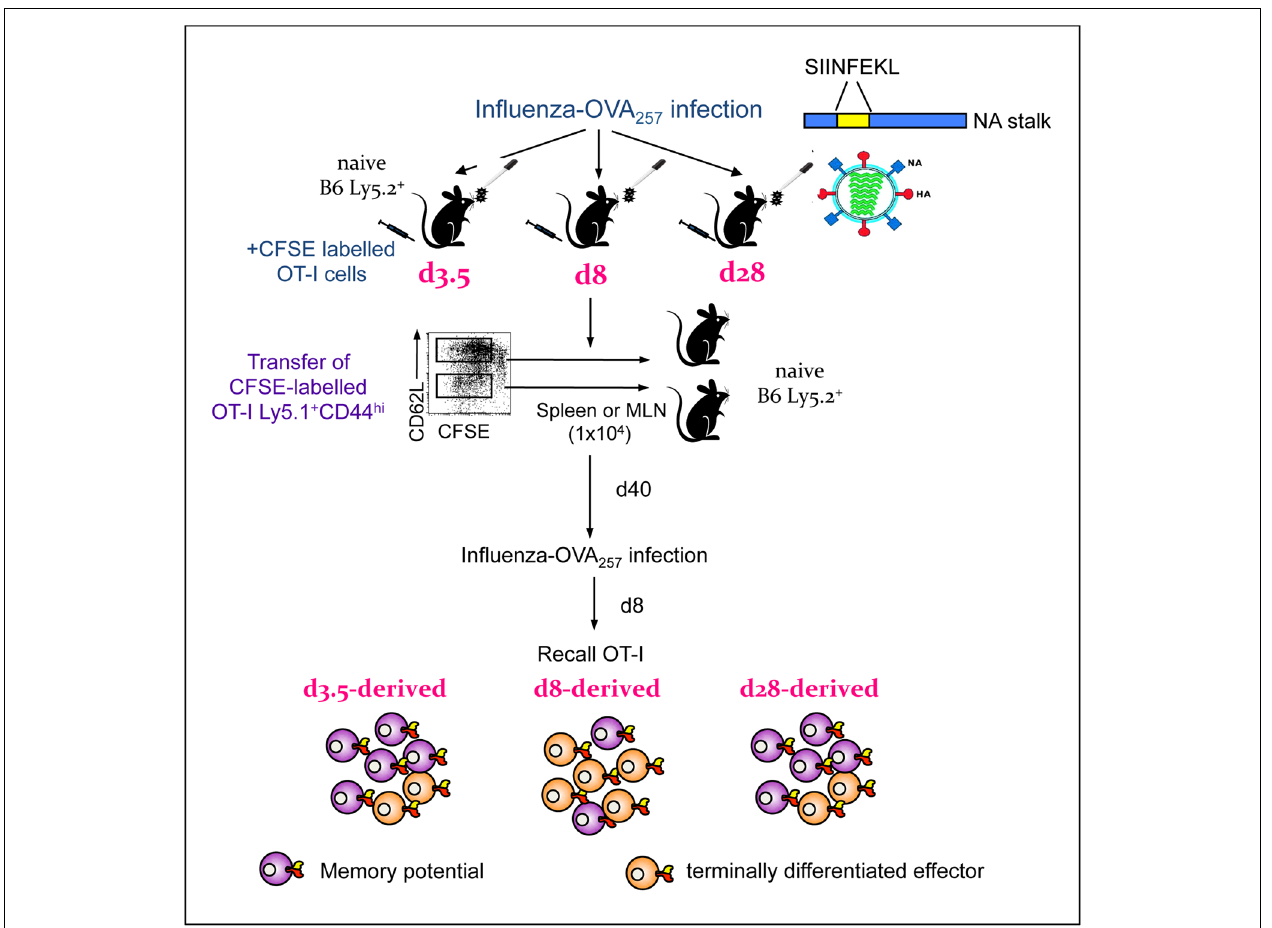
FIGURE 3 | Early establishment and recall of memory precursors in an OT-I transgenic system. Diagrammatic representation of findings published in Kedzierska etal. (2007). OT-I cells were labeled with CFSE, transferred into congenically different B6 mice and infected with an influenza virus expressing the SIINFEKL peptide in the viral NA. On d3.5, d8, or d28 after infection, OT-I CD44 hi cells, which have divided, were transferred into naïve B6 mice. After